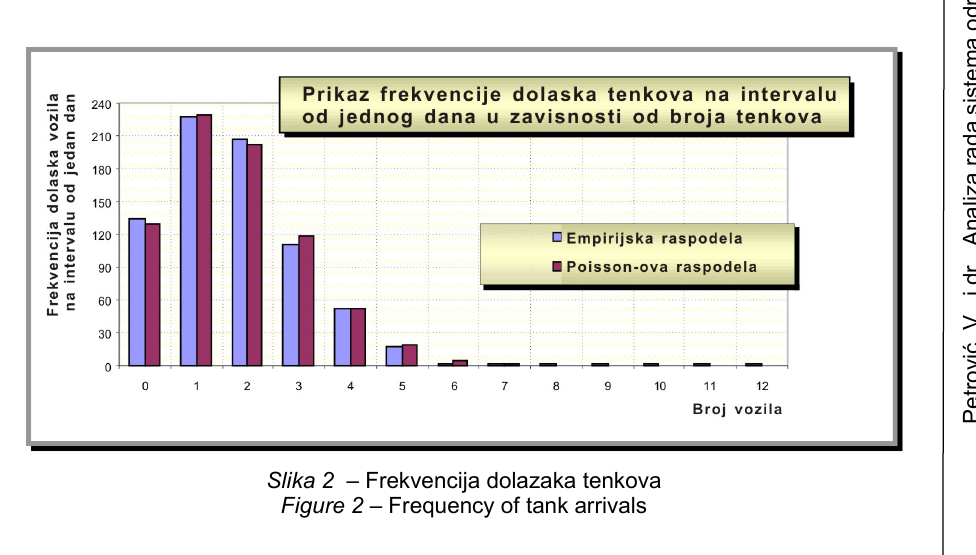
b/v (transportera i tenkova) u intervalu od jednog dana, prema slici